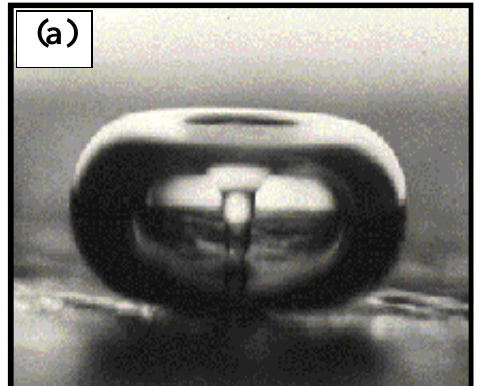
Figure 3. (a) A flash microphotograph (Crum [32]―Figure reproduced with permission ©1982 IEEE) and (b) a schematic representation, of a microjet of liquid streaming through a bubble upon implosion due to cavitation near a solid